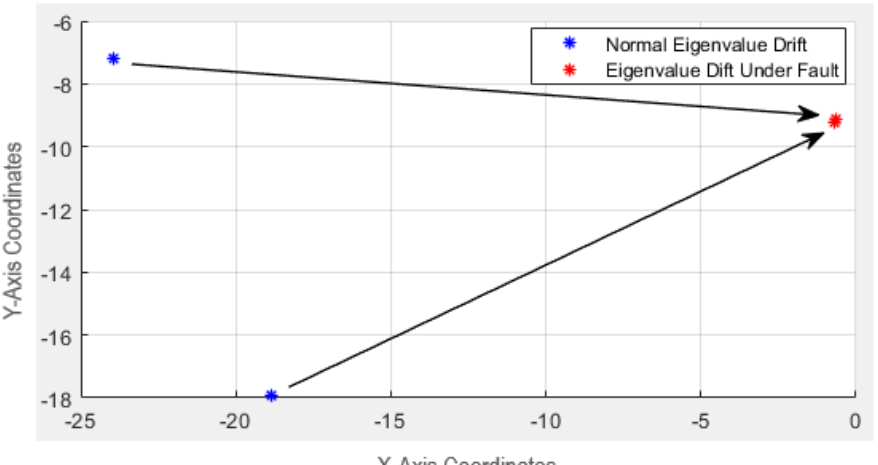
Figure 9. Eigenvalue drift during a fault with a resistance of 10 Ω